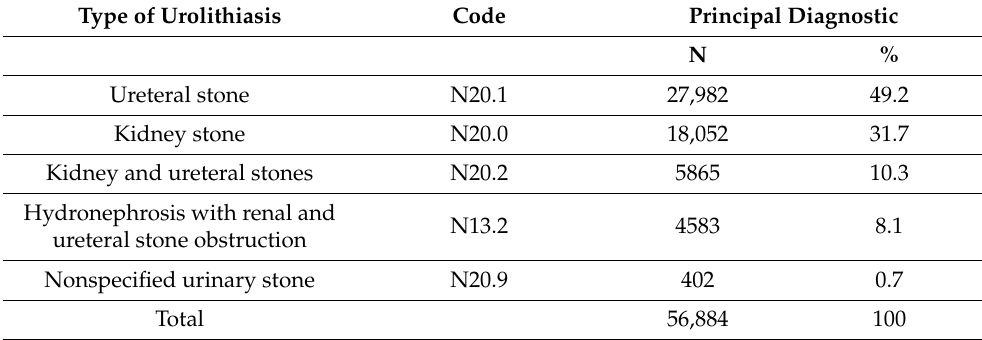
Table 1. ICD-10 codes of kidney and ureteral stones when lithiasis was coded as the main diagnosis. Type of